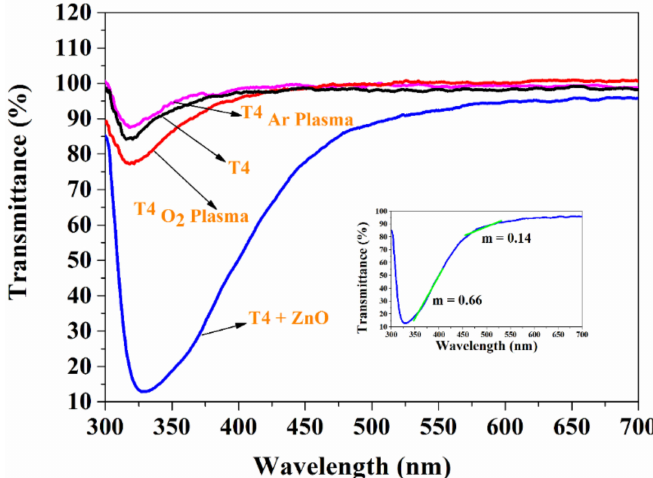
Figure 7. UV-visible spectra of modified T4 films. Inset graph shows the rate of decrease of UV and visible light transmission in two di ff erent regions between 300–400 nm and 450–600